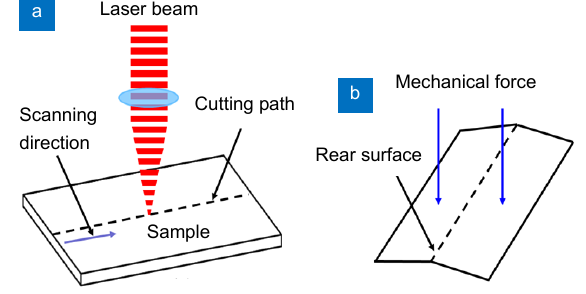
Fig. 2 | Laser scribing and breaking . ( a ) Laser scribing. ( b ) Mechanical breaking. Figure reprinted with permission from ref. 17 ,